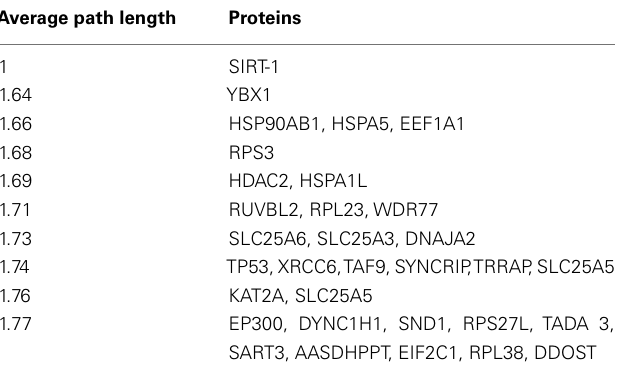
Table 1 |Top 30 neighbors based on smallest average path